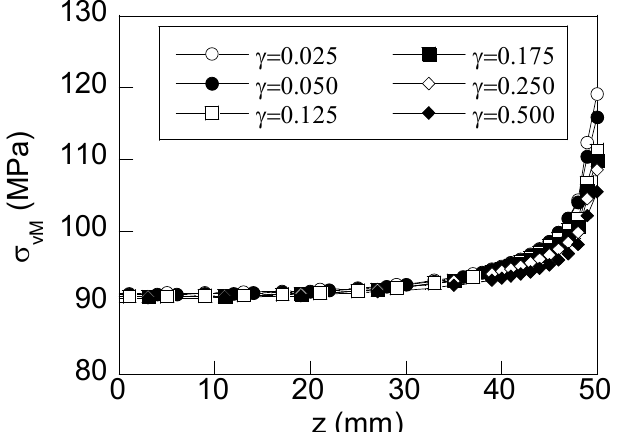
Figure 9. Axial distributions of the tangential stress at the interface contact of the ring/shaft for diverse values of the thickness ratio.